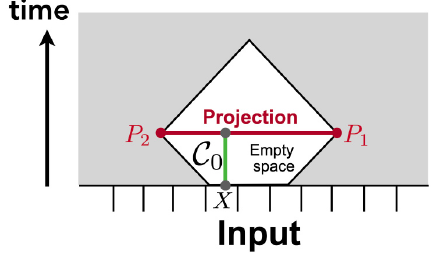
Figure 7 . Configuration with trivial entanglement in line-tension picture.